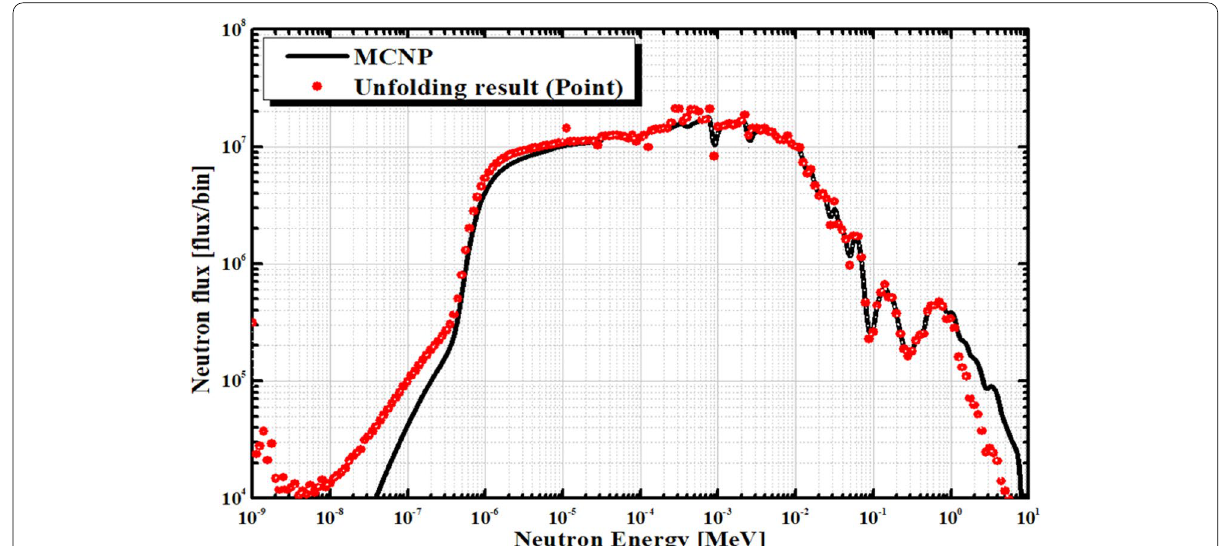
Fig. 19 Neutron energy spectrum as measured by multi‑foil activation and unfolding compared with the MCNP